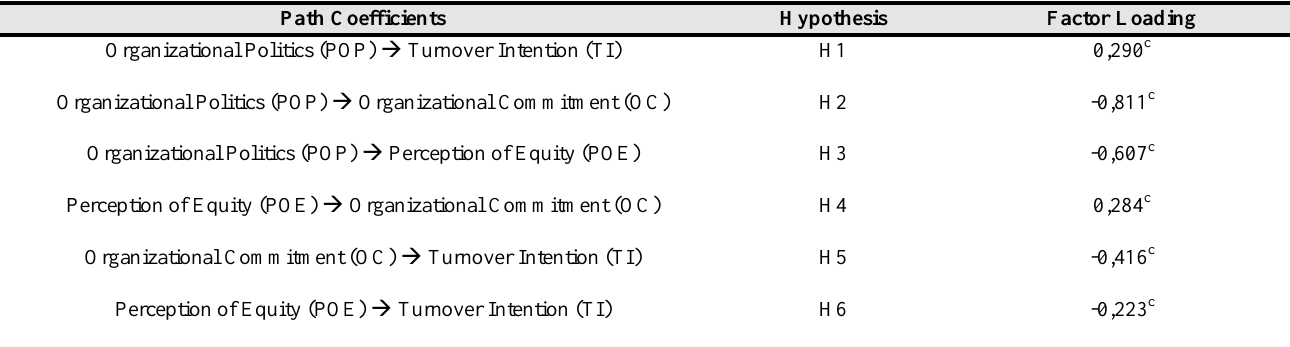
Table 3: Analysis results of the research structural model and related hypotheses Path Coefficients Hypothesis Factor Loading Organizational Politics (POP)  Turnover Intention (TI) H1 0,290